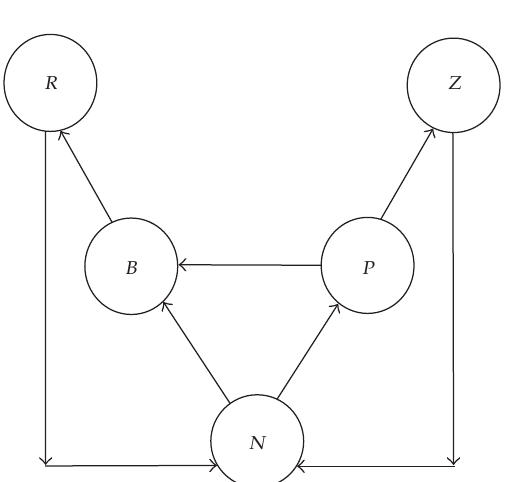
Figure 1: Stone’s Compartmental model showing interaction between components. The direction of the arrows indicates a direct positive influence by one component on another. Here R , B , N , P , Z represent protozoa, bacteria, nutrients, phytoplankton, and zooplankton,